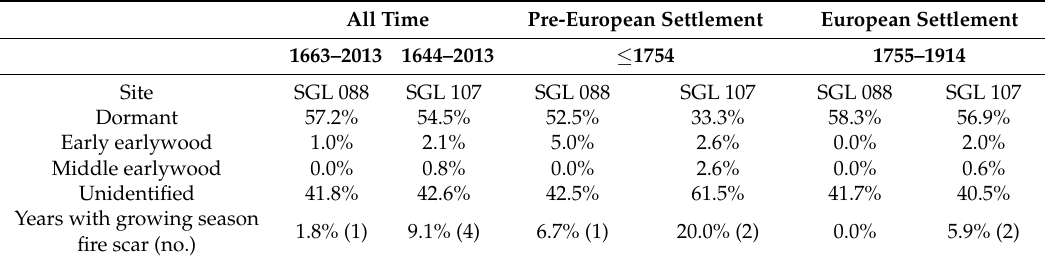
Table 2. Fire ‐ scar position and seasonality of fire scars at SGL 088 and SGL 107 by sub ‐ periods. All Time Table 2. Fire-scar position and seasonality of fire scars at SGL 088 and SGL 107 by sub-periods. All